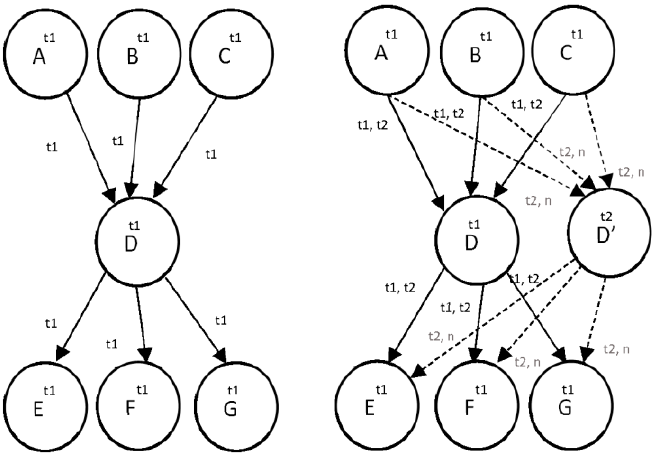
Figure 5. The second approach — adding a new value.